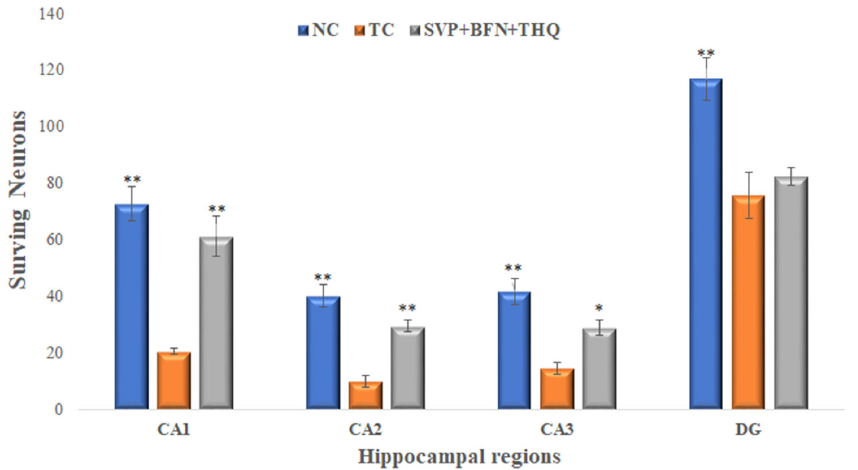
Figure 6. Surviving neurons from hippocampal regions, CA1, CA2, CA3 and DG. * p < 0.05, ** p < 0.01 versus TC. NC; Normal Control, TC; Toxic Control.